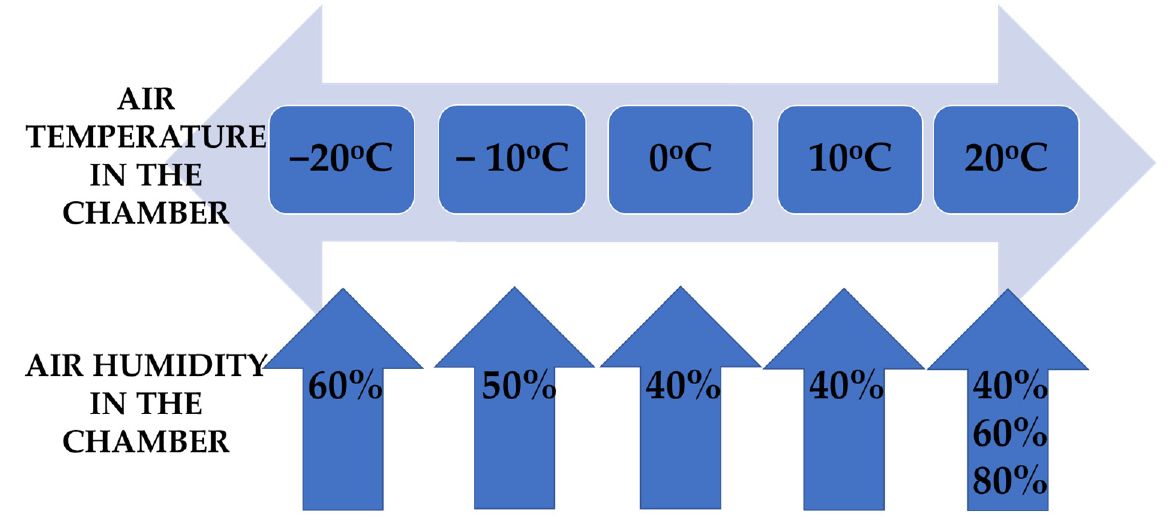
Figure 3. Graphical representation of the range of ambient conditions in the large chamber during testing.